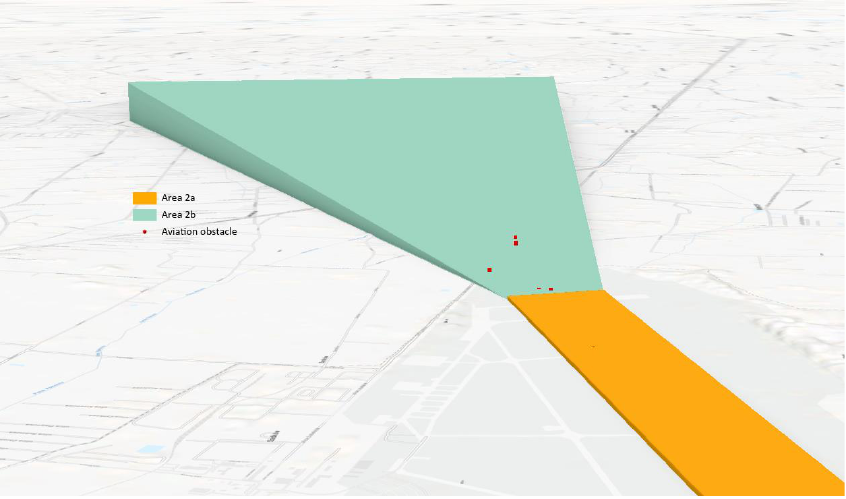
Figure 14. Area 2a and area 2b with atypical aviation obstacles—Airport Radom–Sadk ó